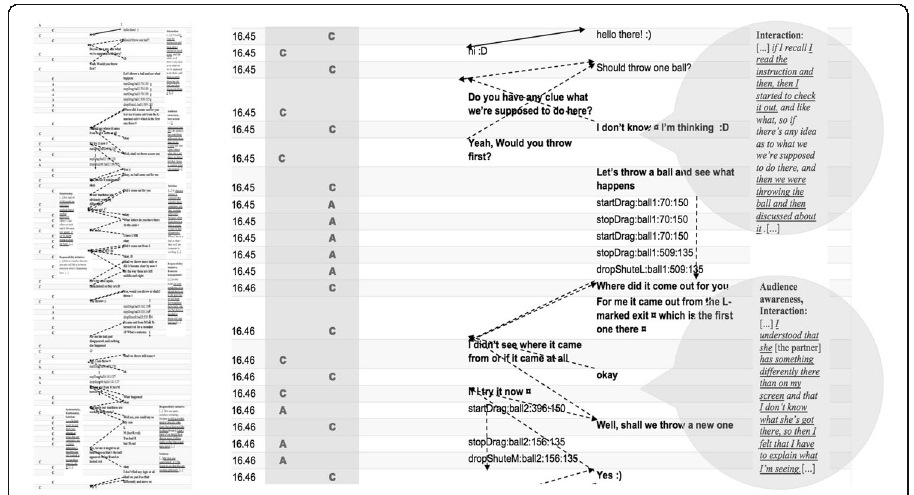
Fig. 6 Joint solution endeavour (pair 24, Laughing Clowns). The full episode as a general pattern of interaction is presented on the left. On the right, an excerpt (indicated as a grey area in the full episode) is presented, including a time-stamped, condensed activity pattern (A = action, C = chat). The dialogue is extracted from the activity log, and the speech bubbles contain excerpts from the coded CRR data that are related to the content of the particular excerpt. (Translated from Finnish). (The full episode is available also in Fig. 10 in Appendix 2)